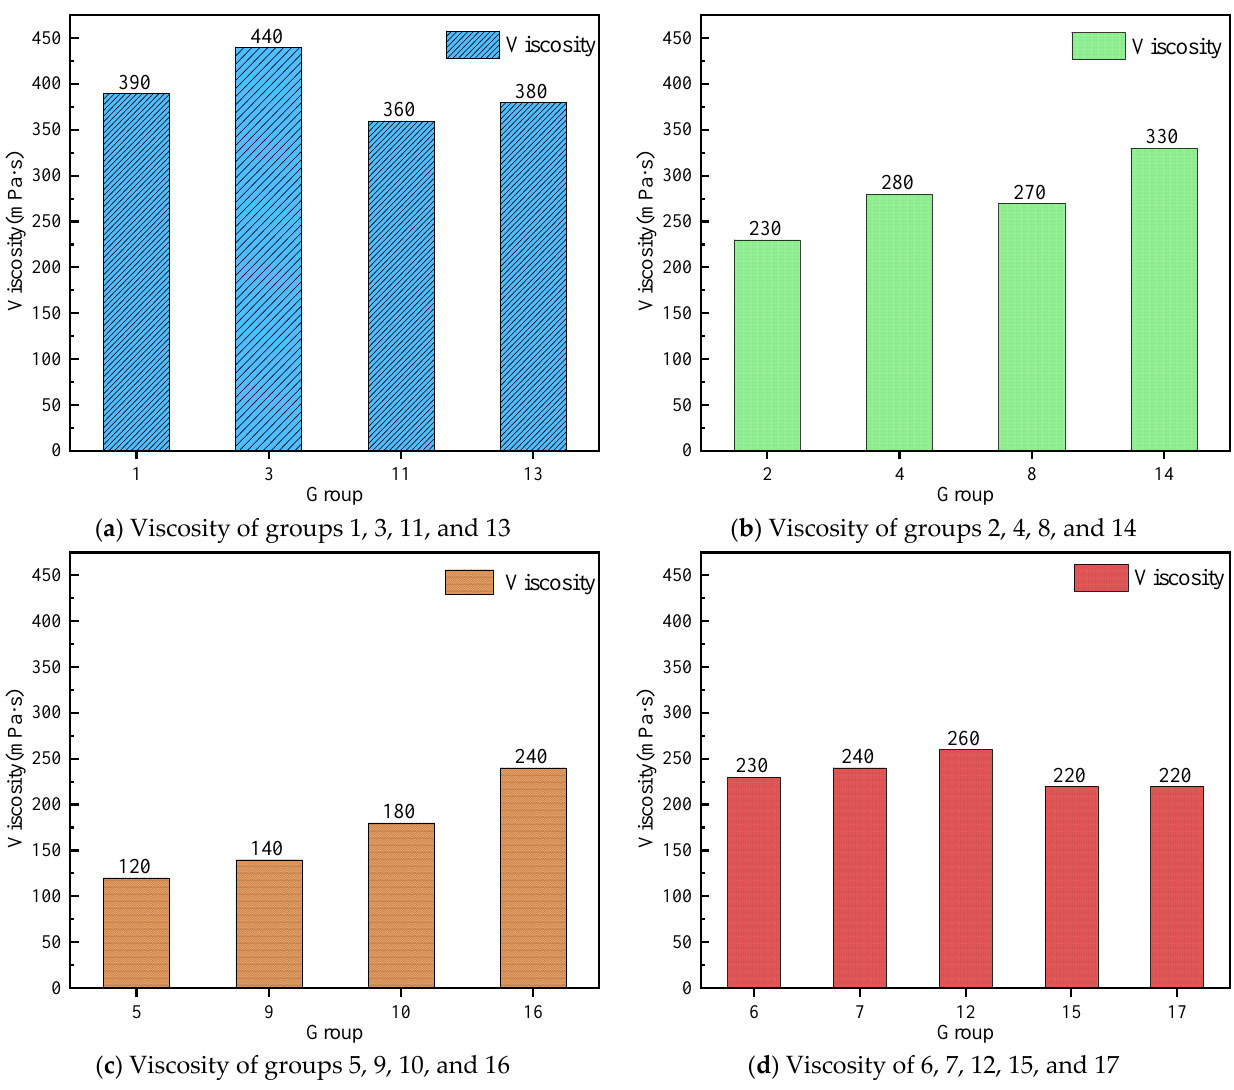
Figure 5. Viscosity of the slurry with different components. ( a ) Viscosity of groups 1, 3, 11, and 13; ( b ) Viscosity of groups 2, 4, 8, and 14; ( c ) Viscosity of groups 5, 9, 10, and 16; ( d ) Viscosity of 6, 7, 12, 15, and